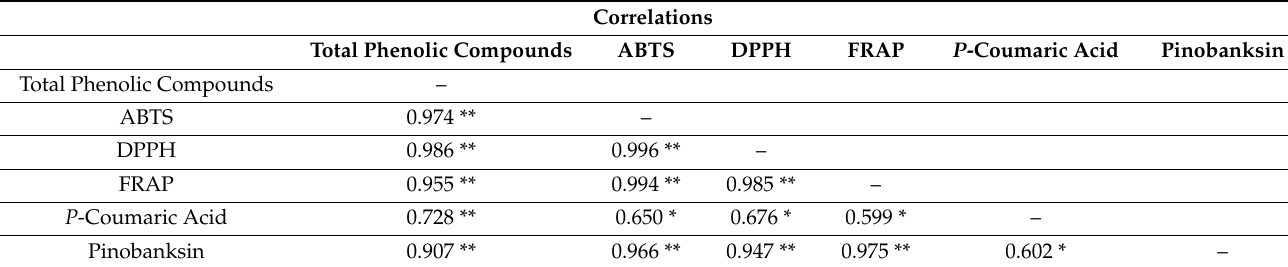
Table 4. Correlation graph of the total phenolic compounds, antioxidant activity (ABTS, DPPH, FRAP), p -coumaric acid and pinobanksin in 70% ethanolic ( v/v ) and aqueous balsam poplar bud extracts by a Pearson correlation. Correlations Total Phenolic Compounds ABTS DPPH FRAP P -Coumaric Acid Pinobanksin Total Phenolic